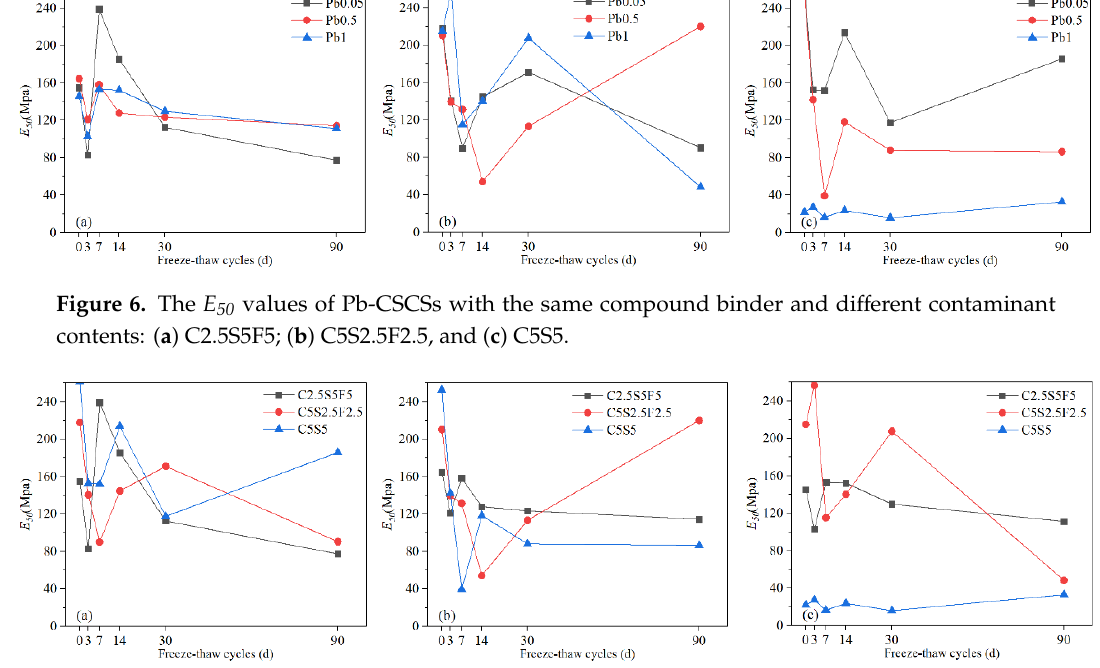
Figure 7. The E 50 of Pb-CSCSs of the same contaminant content and different compound binders: ( a ) 0.05% Pb 2+ ; ( b ) 0.5% Pb 2+ , and ( c ) 1% Pb 2+ .